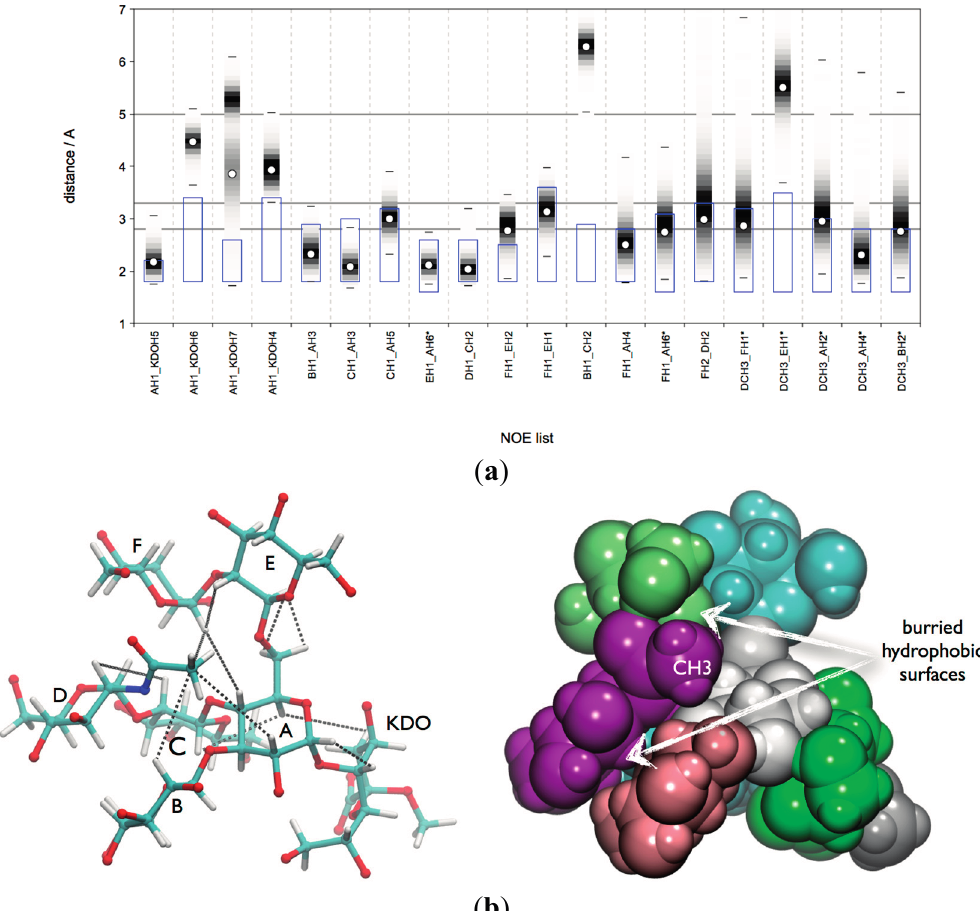
Figure 5. lgt2 Δ OS: ( a ) Comparison of the calculated r eff derived from a 300 ns MD simulation at 300 K of the (1-4)anti- ψ (1-6) gg conformation with the experimental NOE restraints. Calculated average r eff is shown as white circle; histogram of the distances is shown in the background with darker shading meaning higher population. The experimental NOE restraints are indicated with a blue box; ( b ) A representative 3D structure of the (1-4)anti- ψ (1-6) gg conformation. The fulfilled NOE restraints are indicated as dotted lines ( Left ). Space filling model ( Right